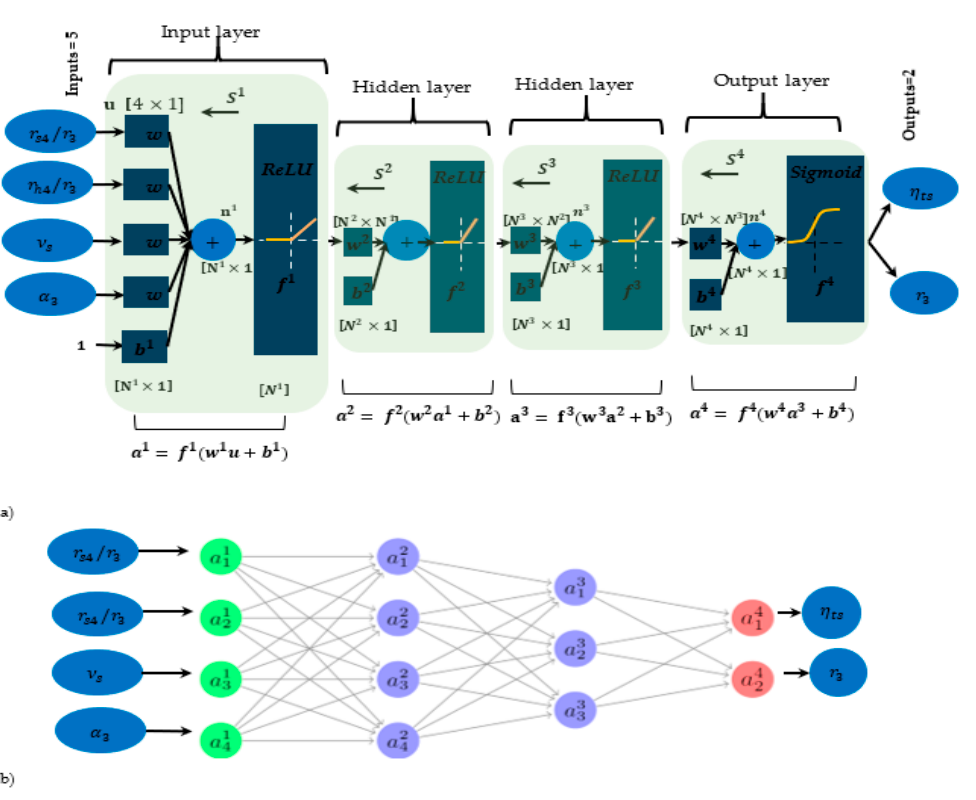
Figure 7. ( a ) Back propagation algorithm of DNN, ( b ) Graphic representation of DNN.